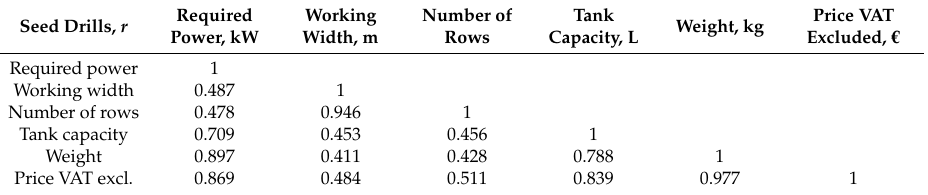
Table 3. Correlation matrix of Pearson coefficient r for functional parameters of seed drills. Seed Drills, r